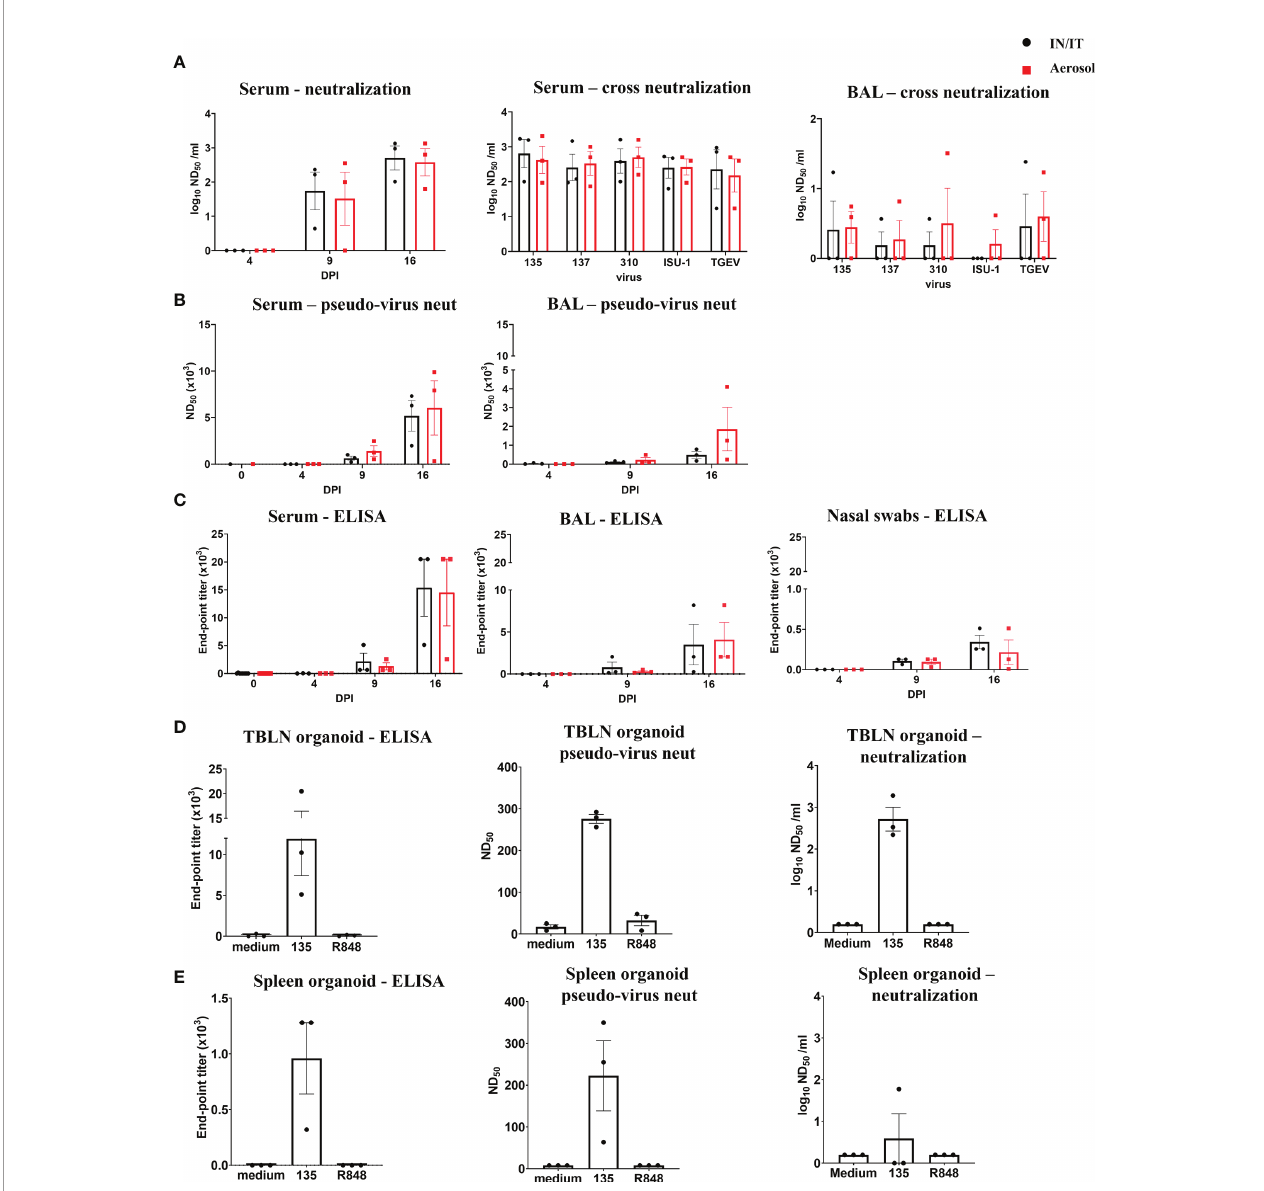
FIGURE 6 | Antibody responses after in vivo challenge with PRCV 135. Serum neutralizing titers at 16 DPI were determined by virus neutralization of PRCV135 (A) . Serum and BAL were also assayed against 135, 137, ISU-1, 310 and TGEV viruses for cross-neutralization. Pseudo-virus neutralizing dose 50 titers were determined for serum and BAL at the indicated time points (B) . Spike (S) speci fi c IgG responses in serum, BAL and nasal swabs were determined by ELISA at the indicated time points (C) . Antibody production after 7days in organoid culture measured by Spike (S) IgG ELISA, pseudo-neutralization and virus neutralization of PRCV 135 ( n =3 pigs from IN/IT from 16 DPI) (D, E) . The top of each bar indicates the mean and the line the SEM. Each symbol represents one